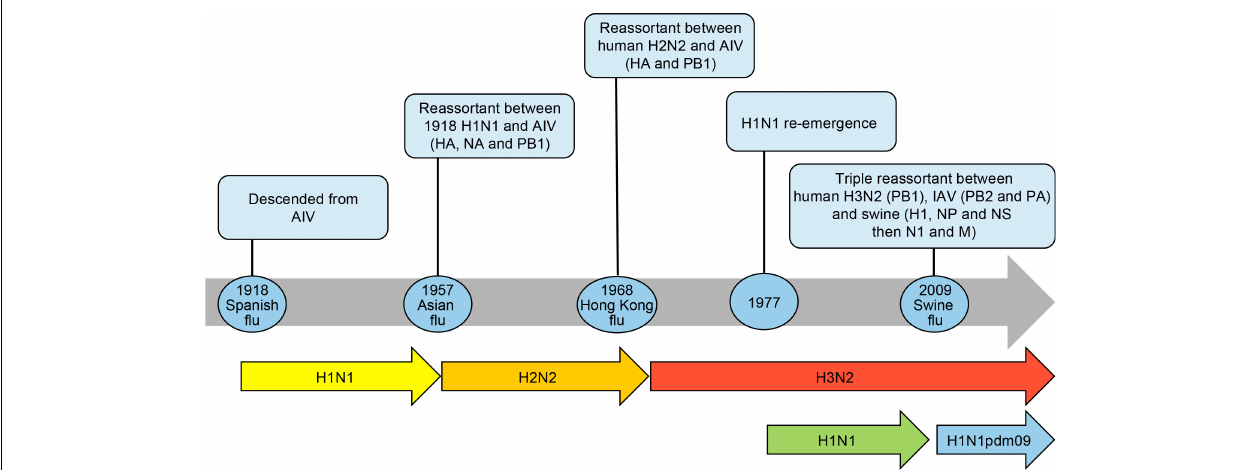
FIGURE 1 | Timeline of influenza pandemics caused by the 1918 H1N1 virus and its descendants produced by reassortment of circulating strains with avian influenza viruses (AIV) and swine H1N1 viruses. The reassortment of genes is shown in parenthesis. The re-emergence of H1N1 virus in 1977 is also shown as it co-circulated with the H3N2 virus before being replaced by the H1N1pdm09. HA, hemagglutinin; NA, neuraminidase; NP, nucleoprotein; M, matrix proteins, PB1 polymerase; PB2 polymerase; PA polymerase; NS, non-structural